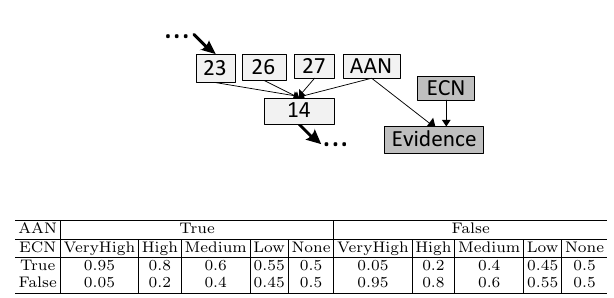
Figure 7. The Evidence-Condidence Pair and Associated Exemplar CPT Figure 6 after adding an AAN node. Correspondingly, the CPT table is modified as in Figure 6. This